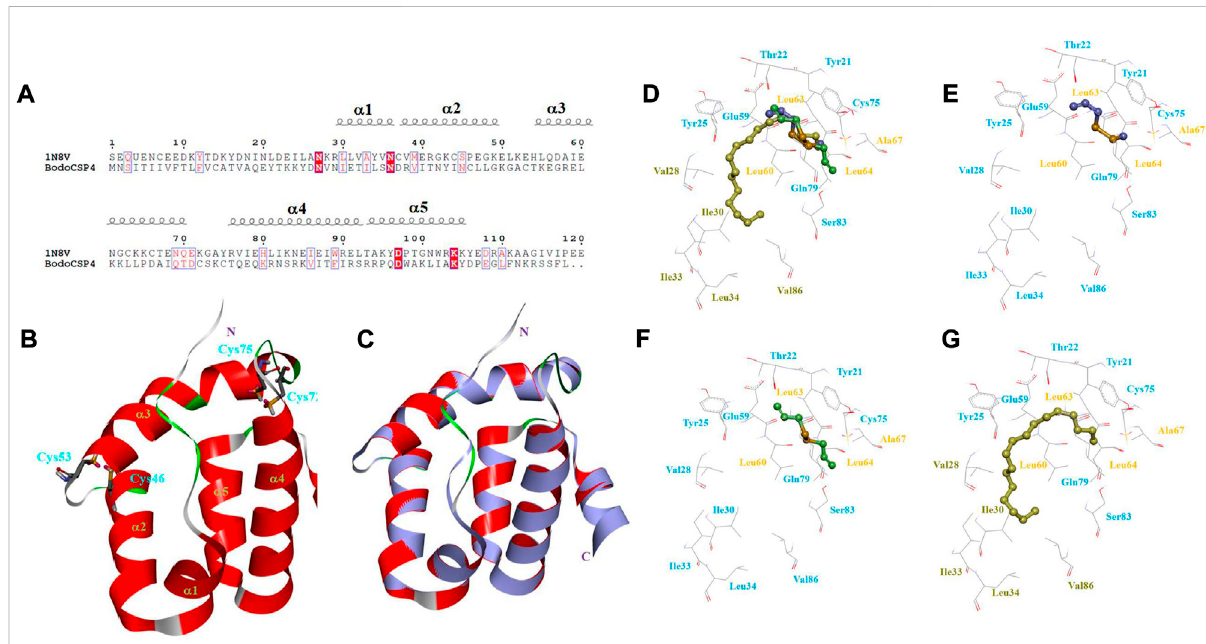
FIGURE 3 3DstructuremodelandbindingcavityofBradysiaodoriphagachemosensoryprotein4(BodoCSP4). (A) SequencealignmentofBodoCSP4and CSPMbraA6 (1N8V). The black spiral coils represent α -helices. (B) 3D model of the target protein BodoCSP4 based on the crystal structure of the template protein of CSPMbraA6; two disul fi de bridges are labeled in blue, and the fi ve α -helices are marked in green. (C) Alignment of the target protein BodoCSP4 (red) and the template protein CSPMbraA6 (purple, 1N8V). 3D models of interactions of the recombinant protein BodoCSP4 with (D) three ligands (diallyl disul fi de, methyl allyl disul fi de, and n-heptadecane), (E) diallyl disul fi de, (F) methyl allyl disul fi de, and (G) and